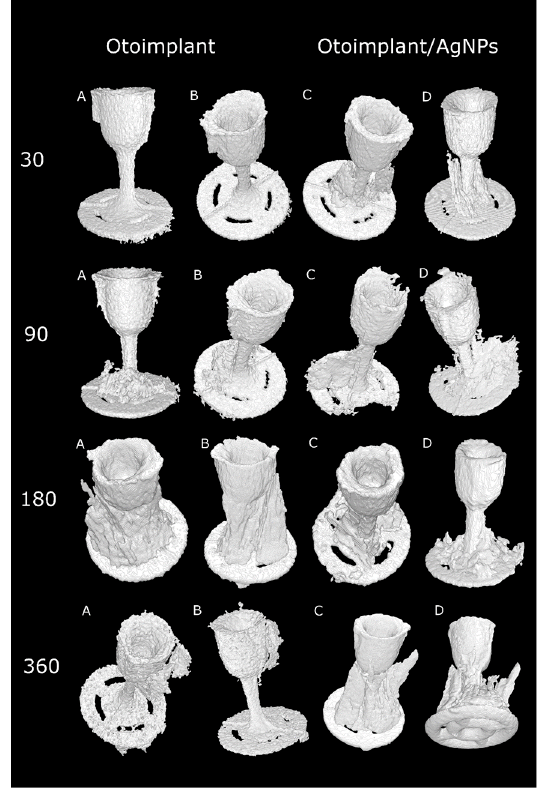
Figure 9. Volume reconstructions showing otoimplant ( A , B —different orientation of prosthesis) and otoimplant/AgNPs ( C , D —different orientation of prosthesis) after 30, 90, 180 and 360 days of the implantation in rats muscles, surrounding granulation tissue visible.